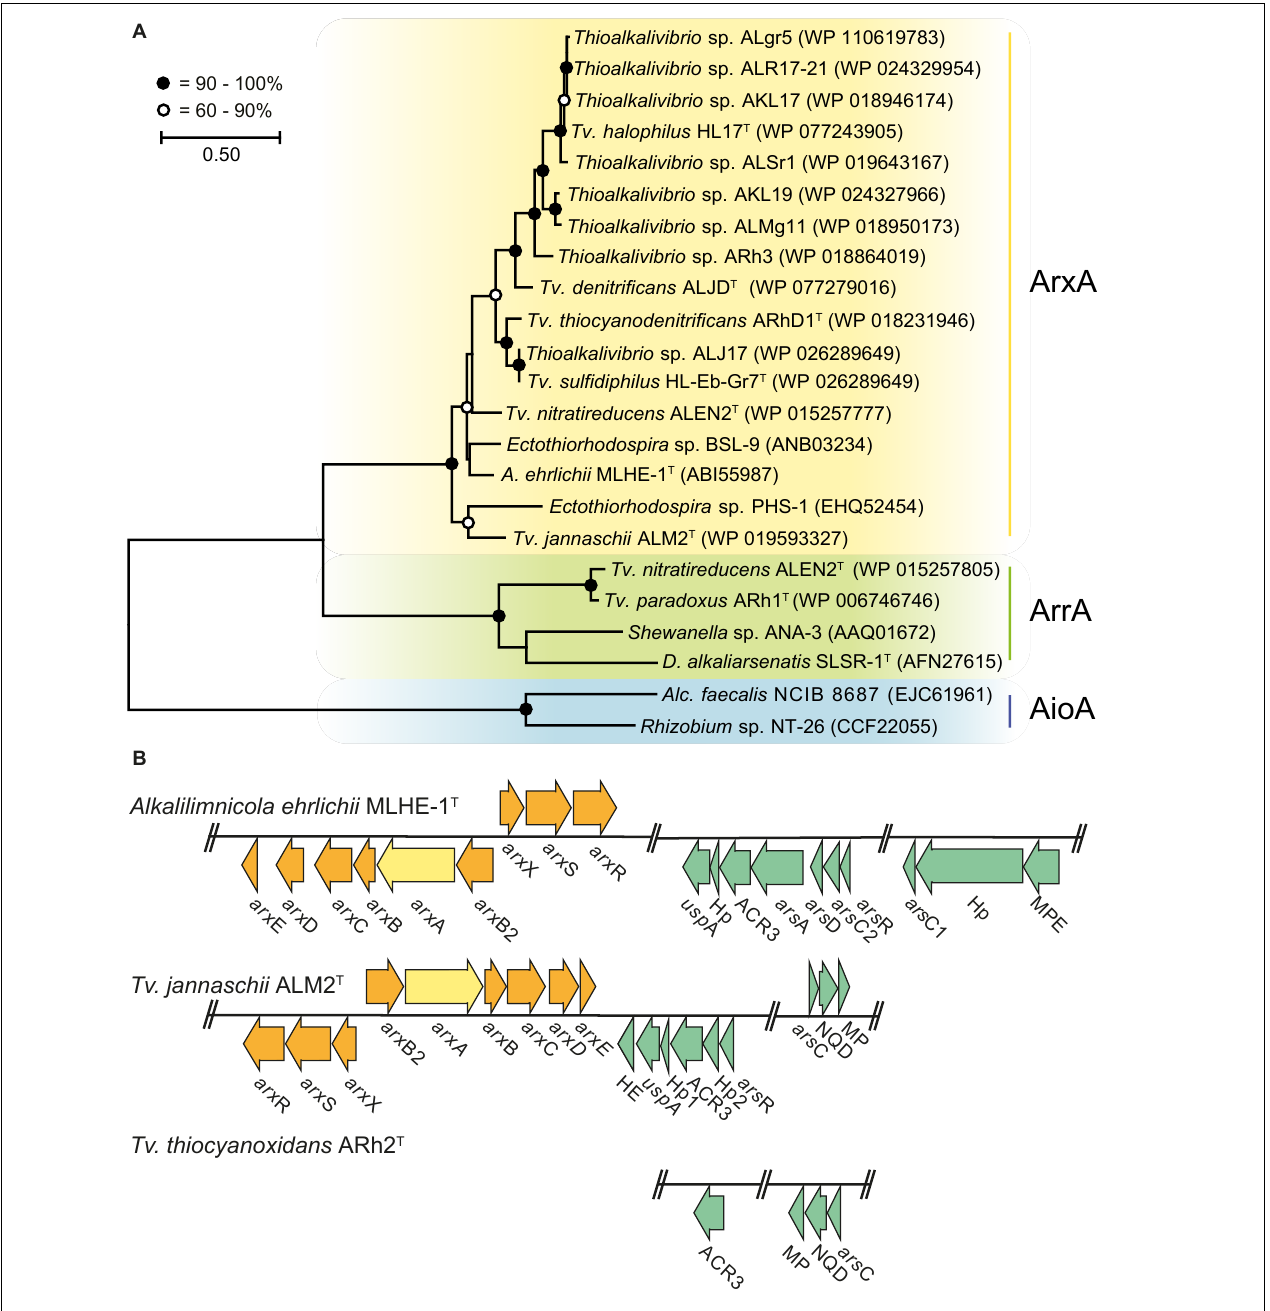
FIGURE 1 | Comparative sequence analysis of arsenic resistance genes in Thioalkalivibrio . Yellow, arsenite oxidase ArxA; green, arsenate reductase ArrA; blue, arsenite oxidase AioA; orange, arsenite oxidase arx gene cluster; turquoise, arsenic resistance ars gene cluster. (A) Phylogenetic tree constructed from ArxA, ArrA, and AioA protein sequences present in the genomes of Thioalkalivibrio strains and other bacteria. Accession number is provided for each sequence in the figure. (B) Arsenic resistance genes in Alkalilimnicola ehrlichii MLHE-1 T , Tv. jannaschii ALM2 T , and Tv. thiocyanoxidans ARh2 T . Hp, hypothetical protein; MPE, metallophosphoesterase; HE, hemerythrin; MP, uncharacterized membrane protein; NQD, NADP(H):quinone dehydrogenase. The locus tags for the genes used in (B) are listed in Supplementary Table 3